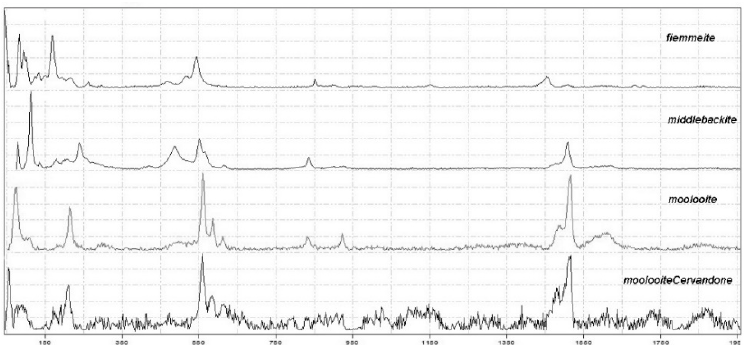
Figure A1. A comparison of the Raman spectra of fiemmeite, middlebackite and moolooite from Passo di San Lugano and moolooite from Monte Cervandone, Val d’Ossola, Italy.